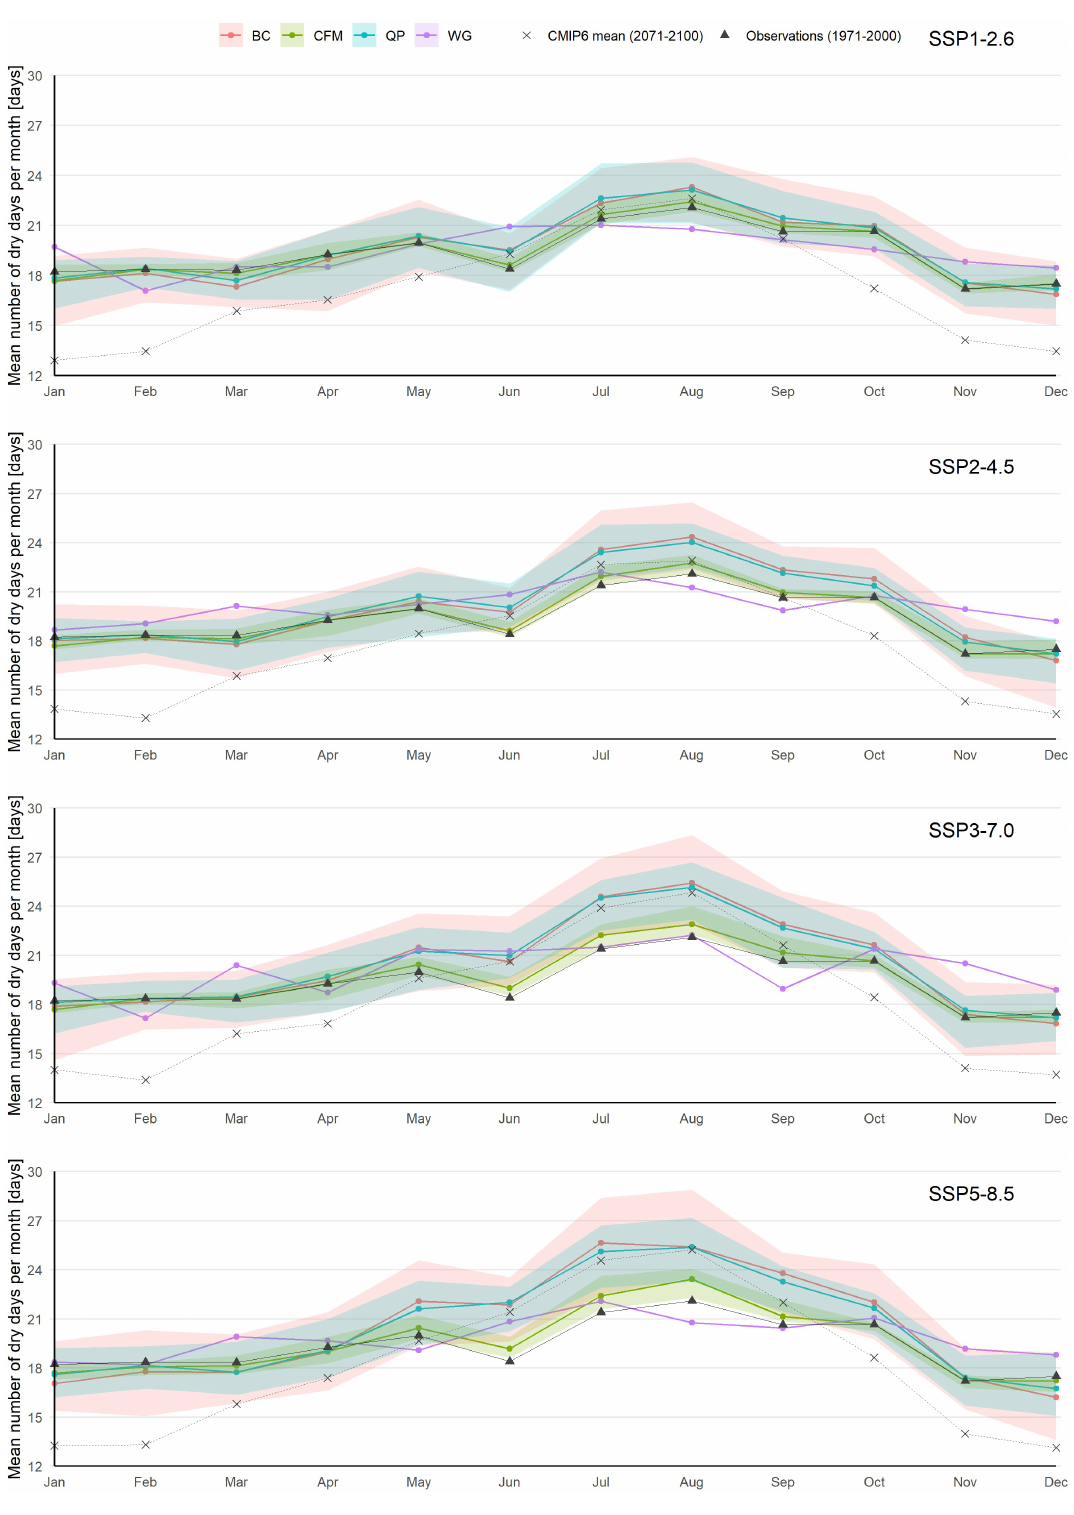
Figure 5. Graphical representation of results for the number of dry days under different future scenarios. Coloured lines represent me- dian values of the ensemble, and shades represent the variation within the ensemble (10%–90% quantiles). CMIP6 GCM projections (not downscaled; dashed line) and Uccle observations (solid line) are given as a